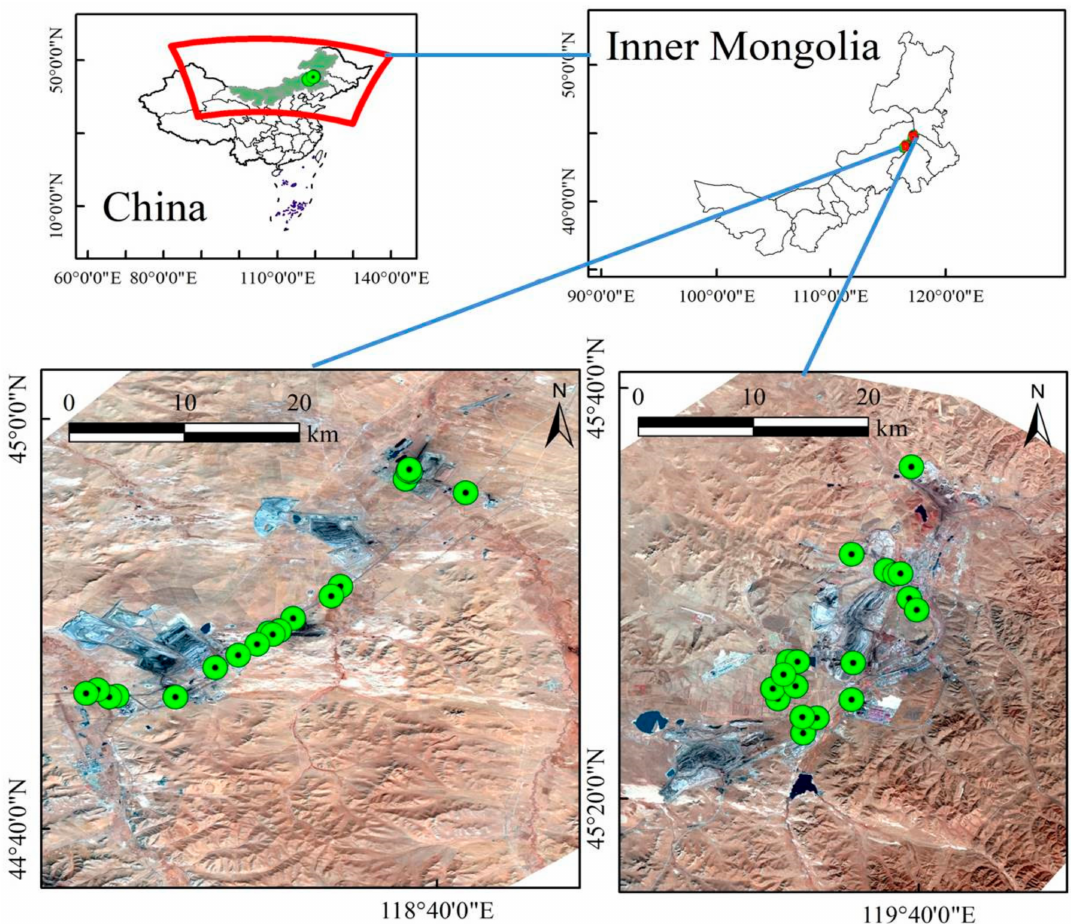
Figure 1. Study areas and sampling